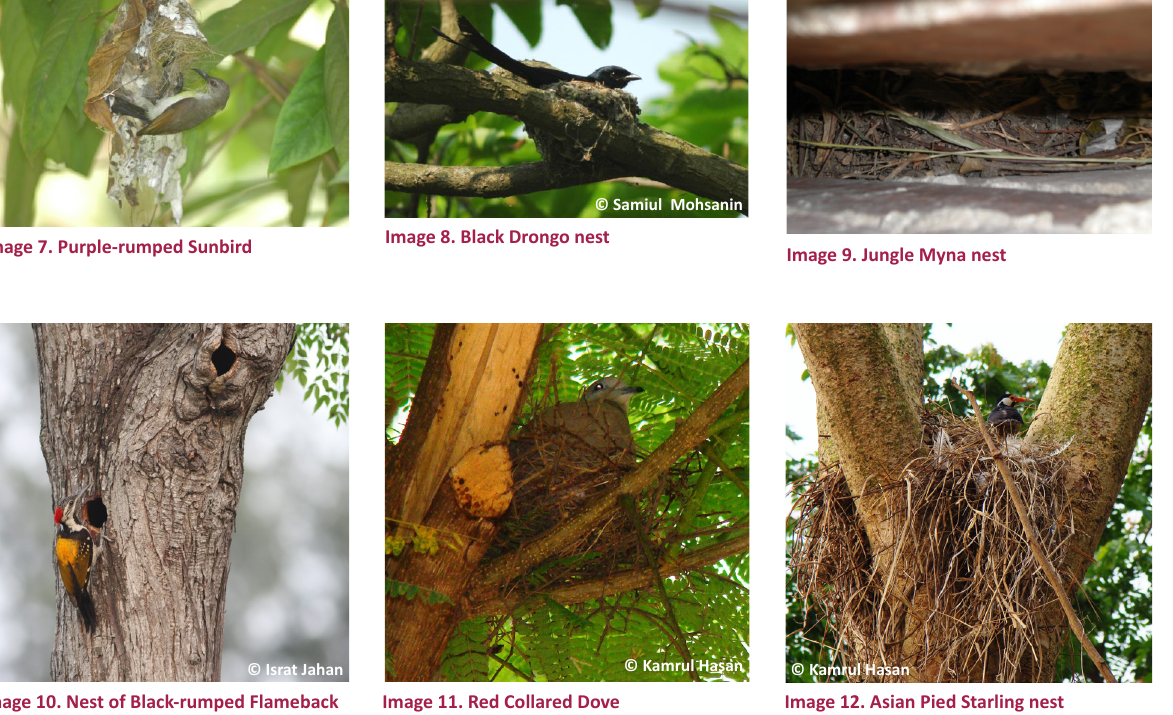
Image 12. Asian Pied Starling